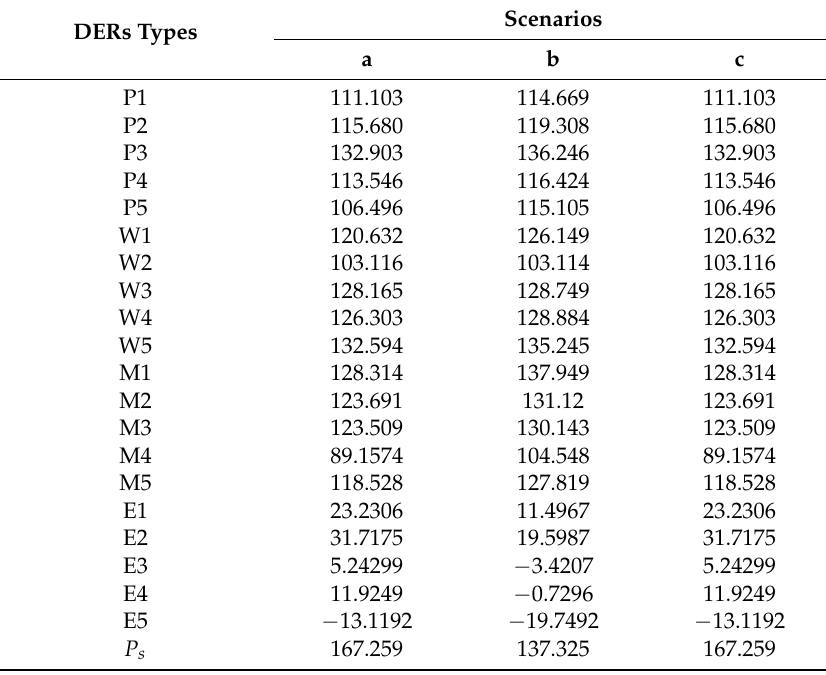
Figure 2. The modified IEEE-34 bus test system in Scenario A. Table 3. Optimal dispatch results under the centralized